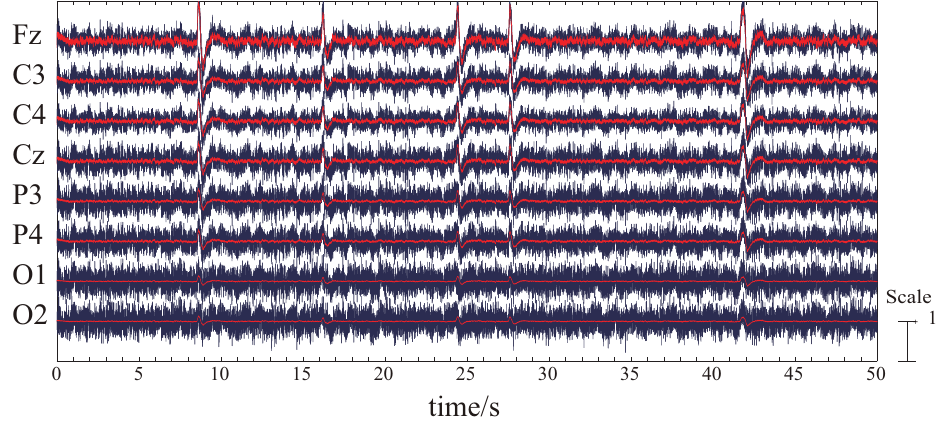
Figure 9. The relationship and influence between eye-blink component and EEG signals. The blue line is measured EEG signals, and the red line is the eye-blink component of Figure